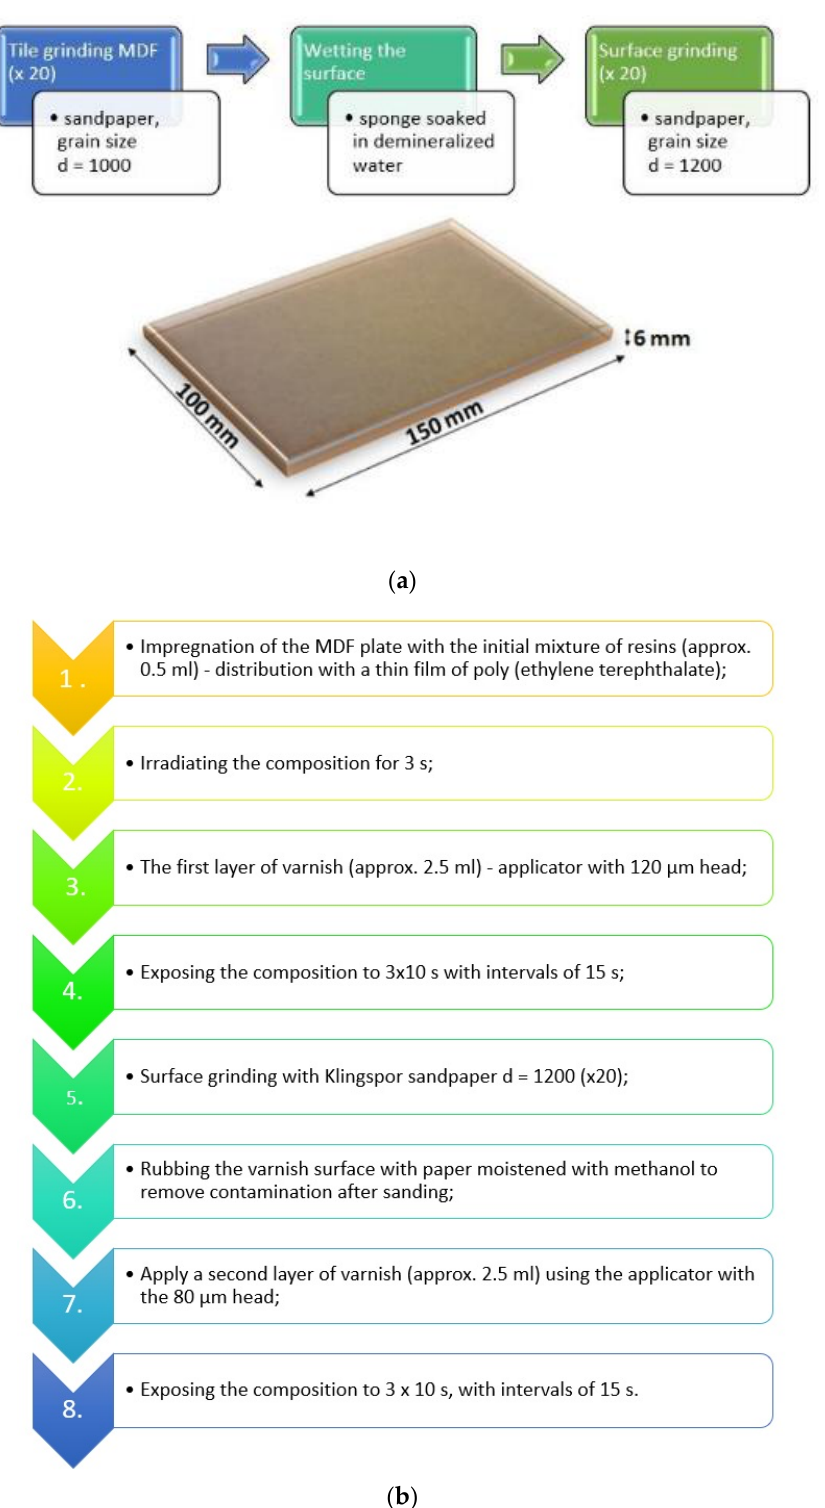
Figure 1. Schematics of coating of substrate: ( a ) preparing MDF boards for lacquering, ( b ) performance of coatings.